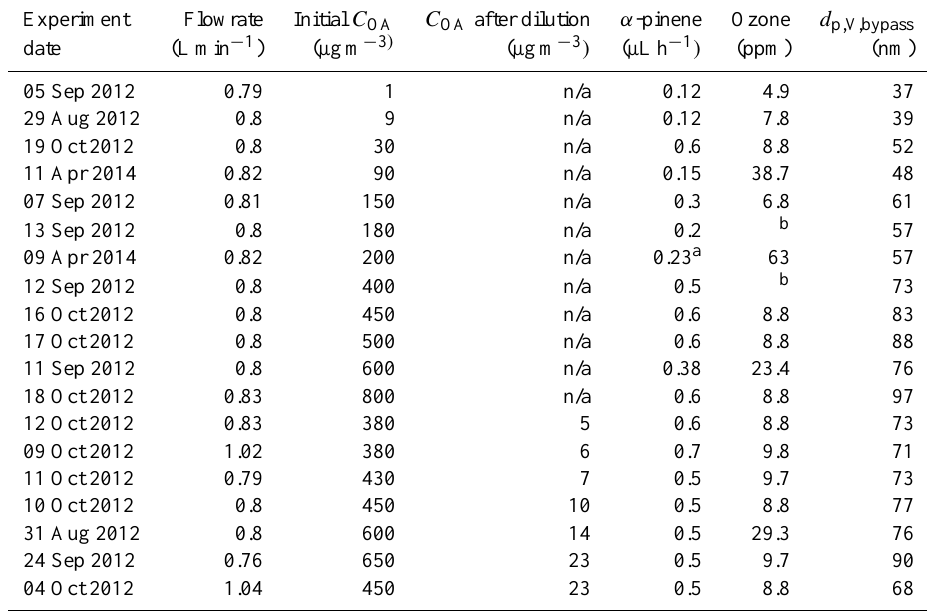
Table 1. Experimental conditions for α -pinene + O 3 SOA generation for the various experiments. Experiment Flowrate Initial C OA C OA after dilution α